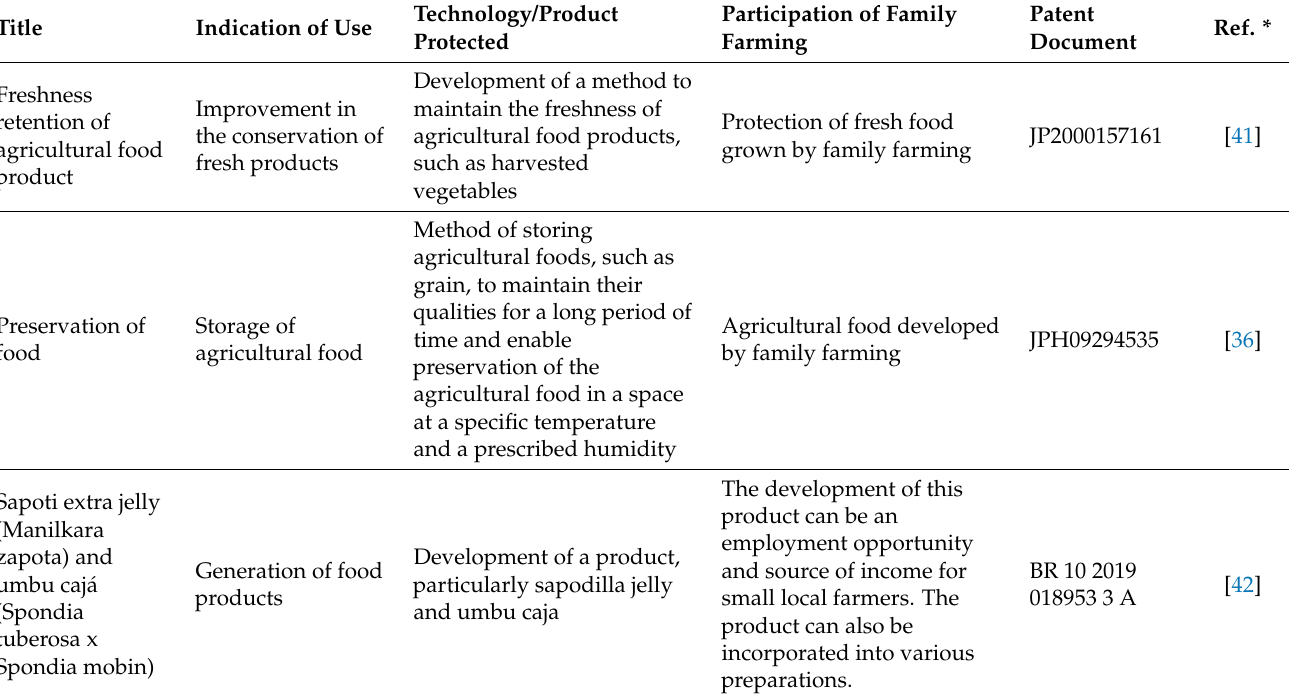
Table 2. Main information on patents that reported the direct association of family farming in the development of new food